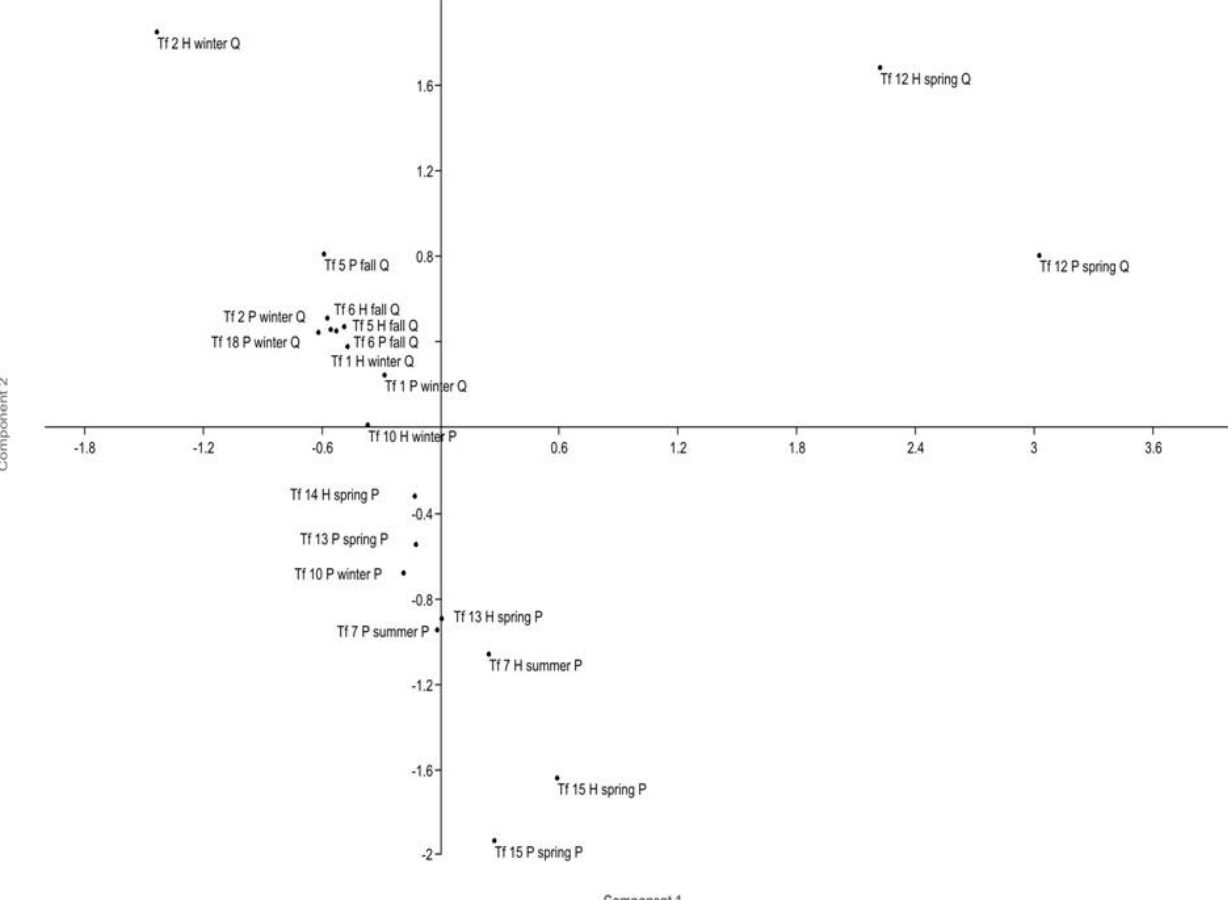
Fig 2 . Two-dimensional graph of the Principal Components 1 and 2 showing the distribution of store